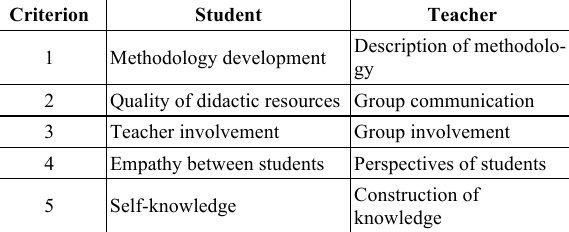
TABLE II. C RITERIONS OF STUDENTS AND